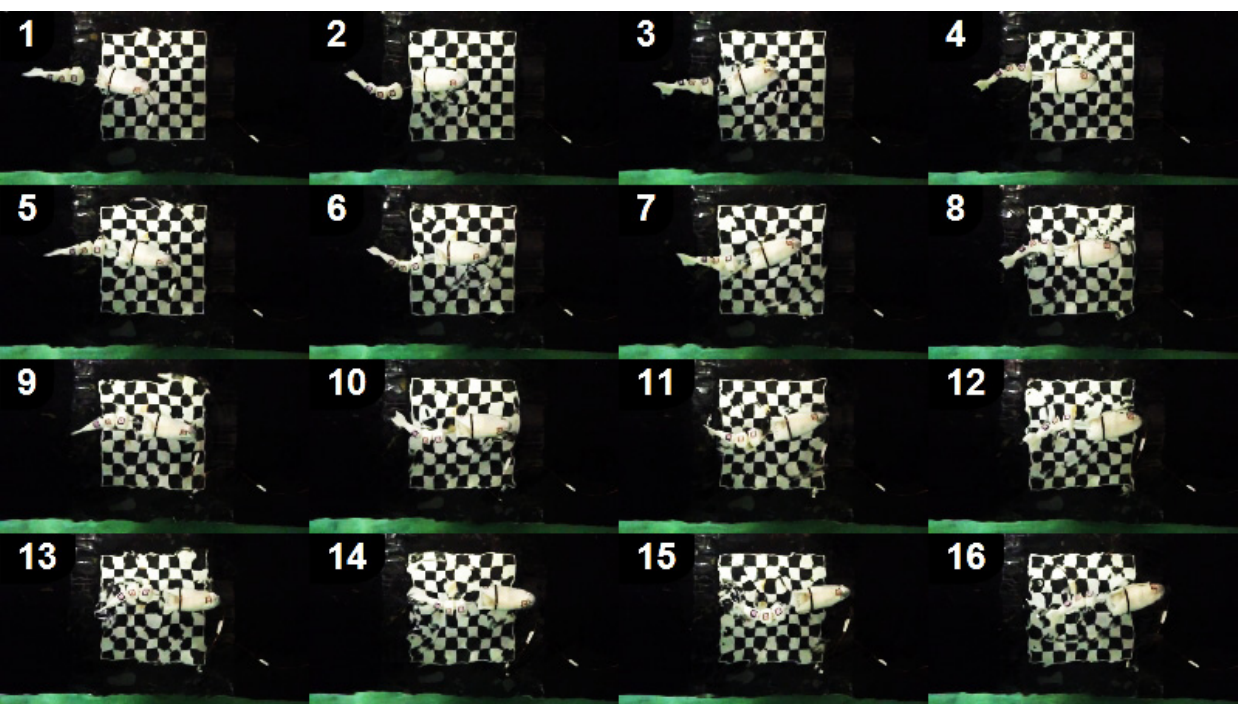
Figure 10. Sequence of images of the robotic fish swimming with a tail beat frequency of 2